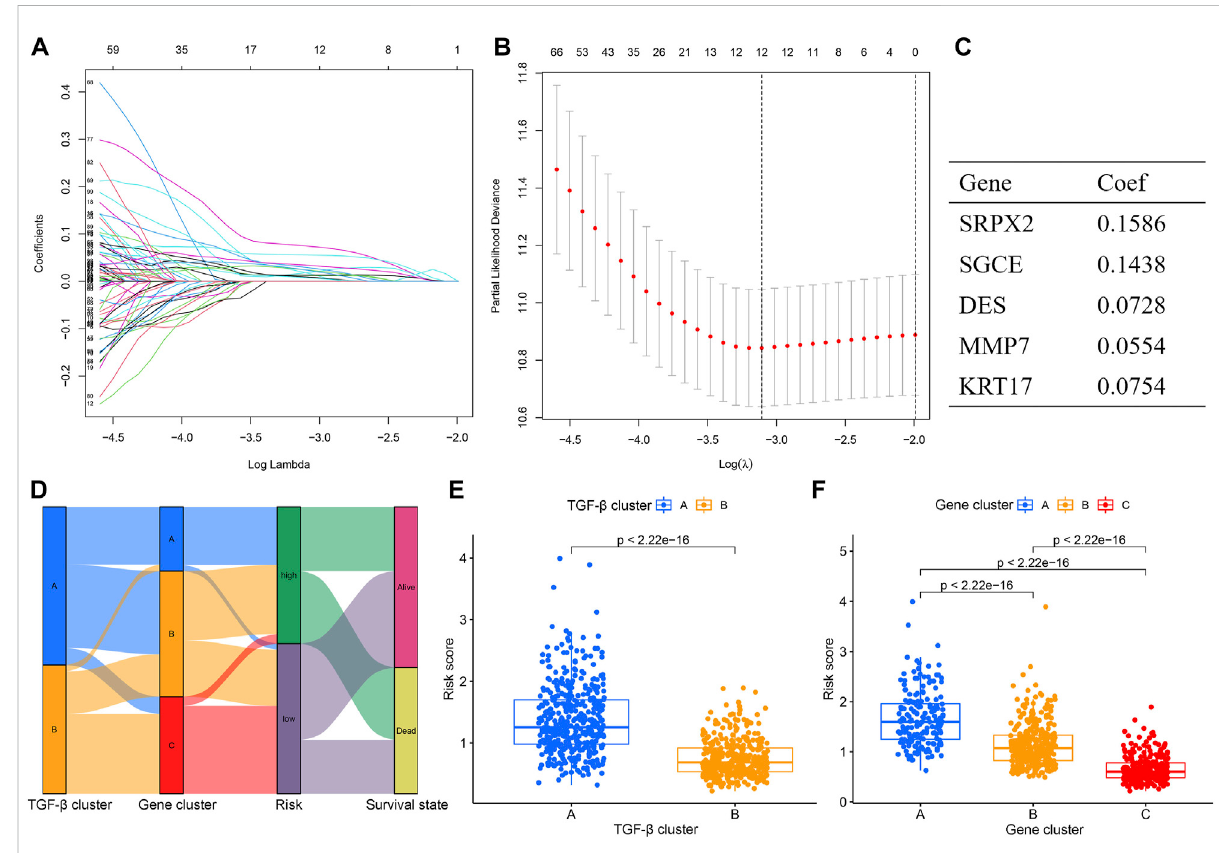
FIGURE 5 Construction of the TGF- β cluster-related DEGs prognostic model. (A,B) Twelve optimal TGF- β cluster-related DEGs were found using the LASSO cox regression. (C) Five optimal TGF- β cluster-related DEGs were found using the multivariate Cox analysis. (D) Sankey diagram of TGF- β cluster, gene cluster, risk score, and survival status. (E) Differences in risk score between two TGF- β clusters. (F) Differences in risk score between three gene clusters. DEGs, differentially expressed genes; LASSO, least absolute shrinkage and selection operator; Coef, coef fi